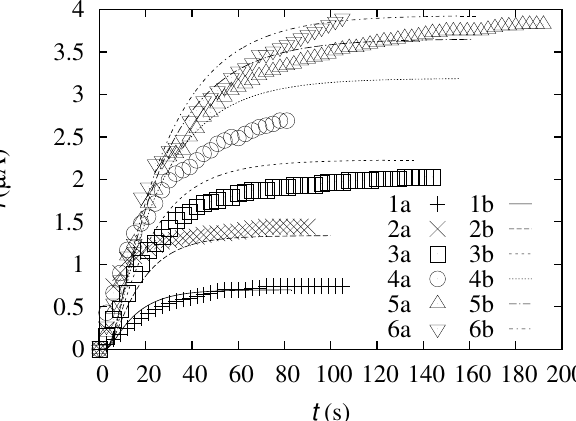
Figure 3. The dynamics of the biosensor current at different values of the substrate concentration, s : 0 . 49 mol/m 3 (1), 0 . 99 mol/m 3 (2), 1 . 99 mol/m 3 (3), 4 . 98 mol/m 3 0